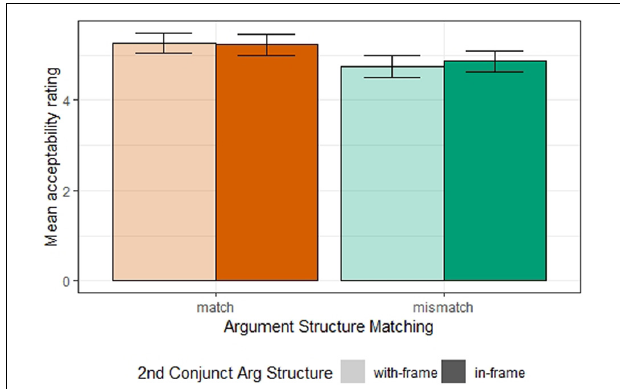
FIGURE 1 | Mean acceptability ratings for all conditions (Experiment